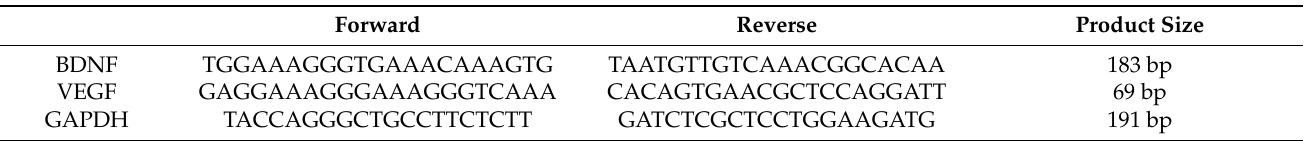
Table 1. Primer sequences